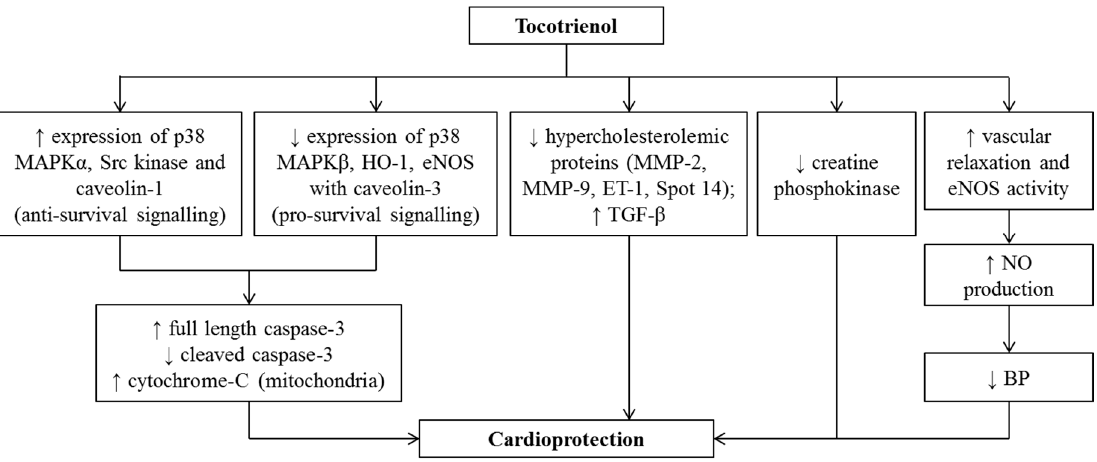
Figure 2. Cardioprotective effects of T3.